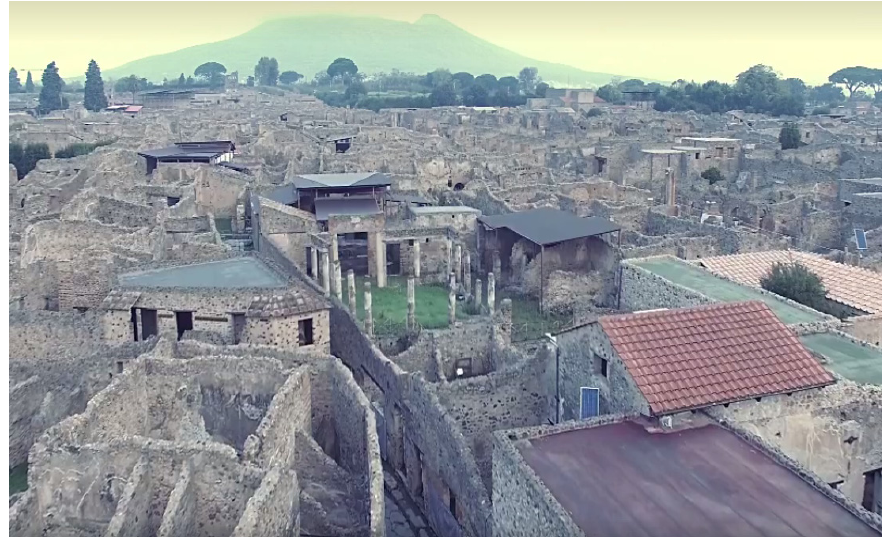
Figure 3. The aggregate of Championnet houses before restoration.